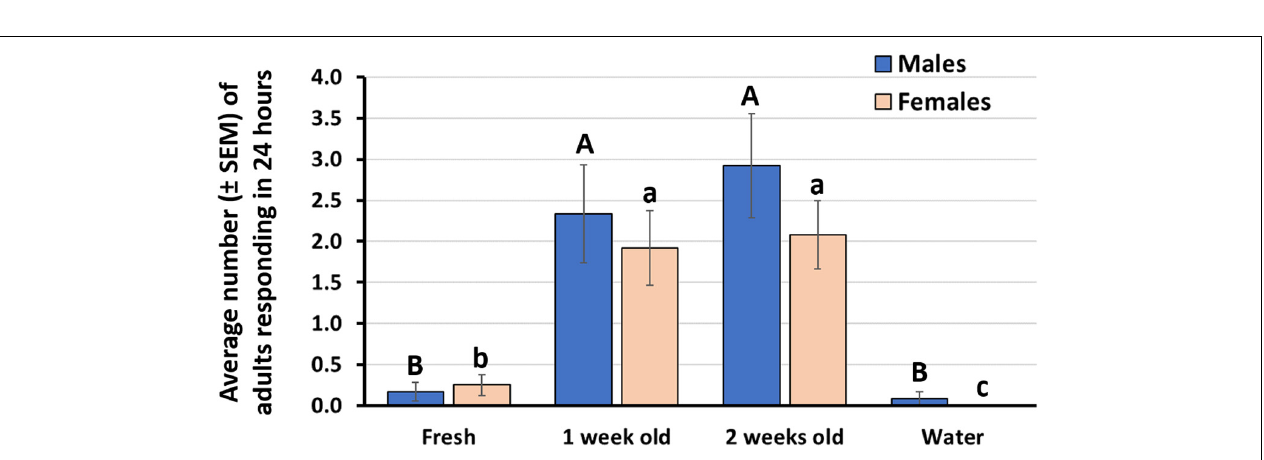
FIGURE 4 | Response, expressed as the mean percentage ( ± SEM) of male and female D. suzukii captured over a 24-h period in cage tests, to diluted grape juice either, fresh or aged for 1 and 2 weeks. For each fly gender, means superscribed by different letters indicate significant differences according to ANOVA and HSD Tukey tests at P =